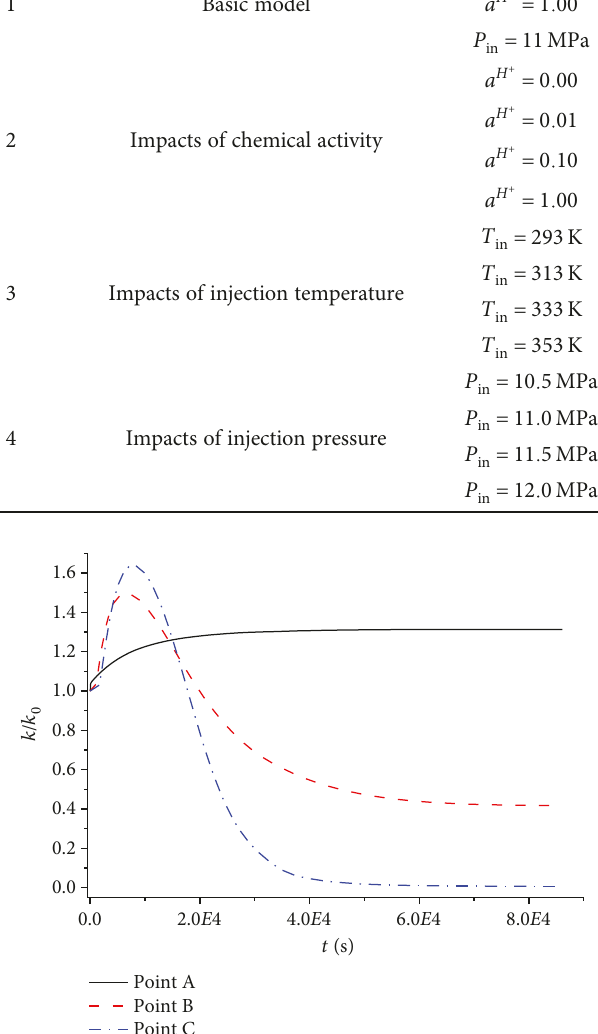
Figure 11: Evolution of permeability ratio k / k